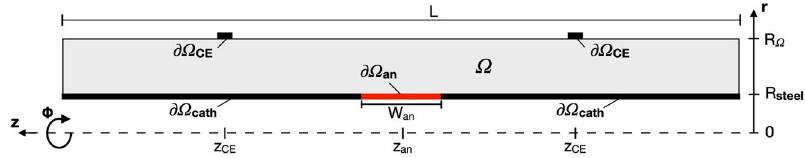
Fig. 9 Schematic overview of the 2D axisymmetric representation. The system is symmetric around the z- axis. In red the anodic metal surface, surrounded by cathodic surfaces (black).